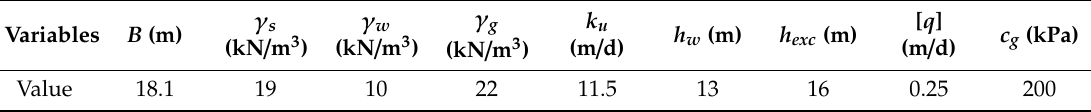
Table 2. Calculating